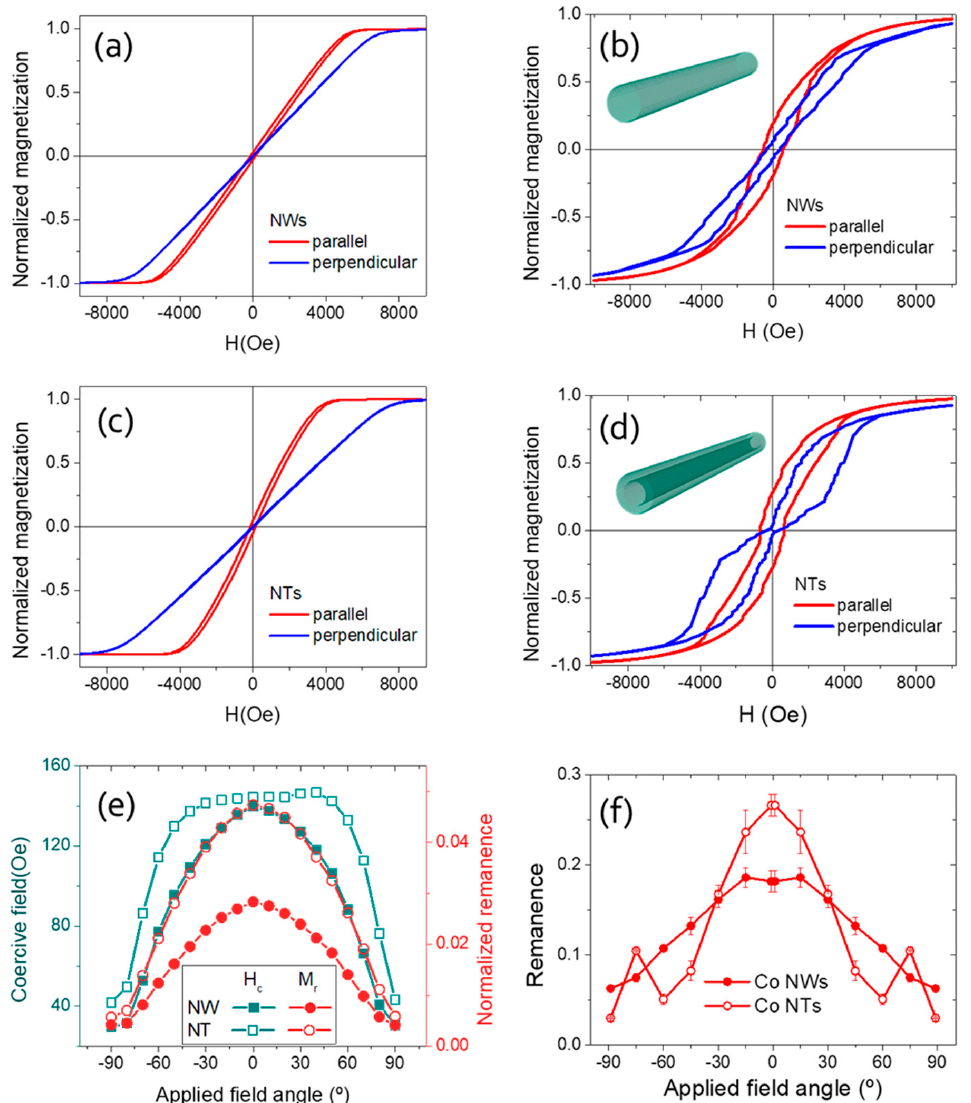
Figure 3. Experimental hysteresis loops for arrays of ( a ) nanowires and ( c ) nanotubes, respectively. Micromagnetic modelled loops of the arrays modelled in individual nanowire ( b ) and nanotube ( d ) with an effective ‘interaction’ anisotropy; ( e ) angular dependence of experimental coercive field and normalized remanence for nanowire and nanotube arrays; and ( f ) angular dependence of simulated